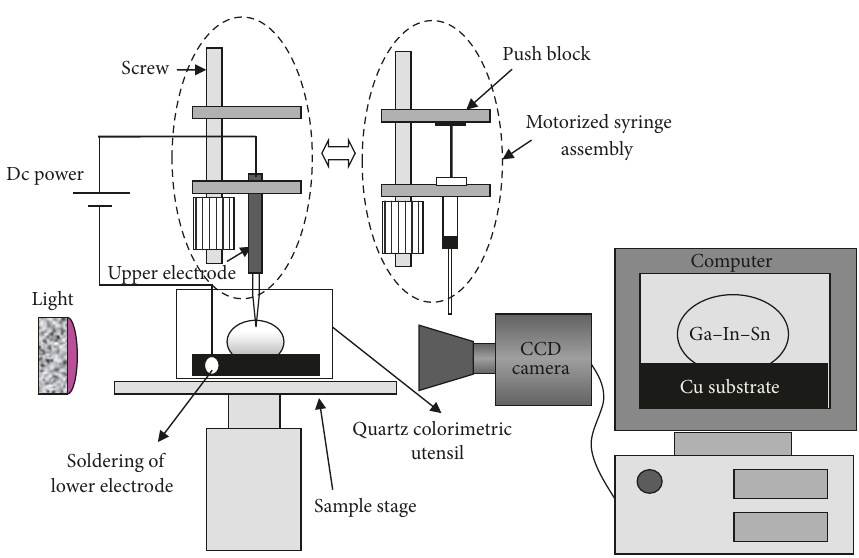
Figure 1: Schematic illustration of direct current-sessile drop